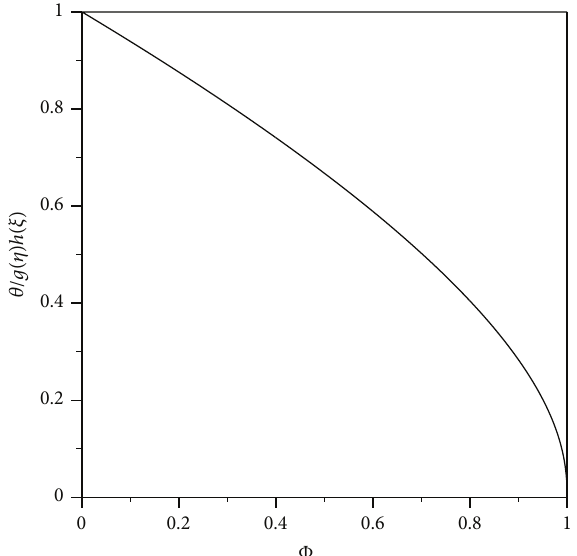
Figure 7: Relationship between parameters of B and 𝜃